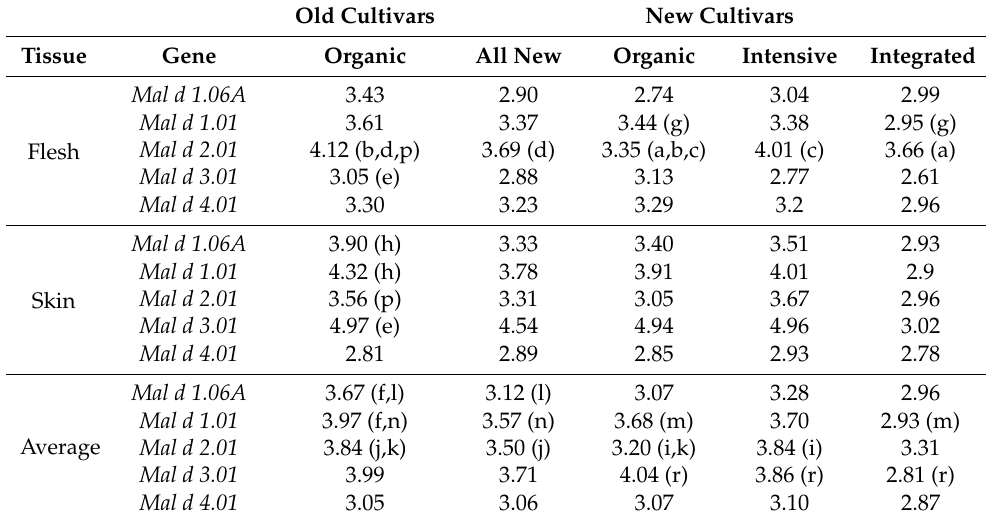
Table 1. Mean expression of genes encoding four main apple allergens in arbitrary units